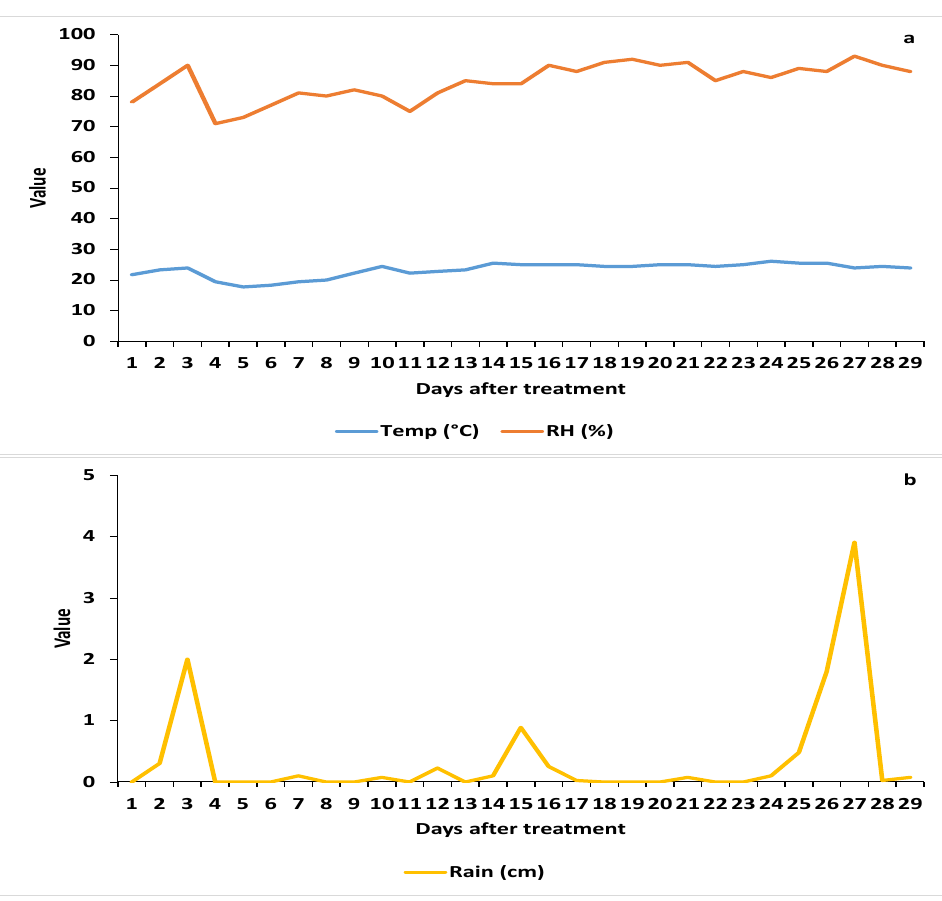
Figure 4. Daily weather parameters during the study in 2019: ( a ) mean temperature and relative humidity; ( b ) precipitation.